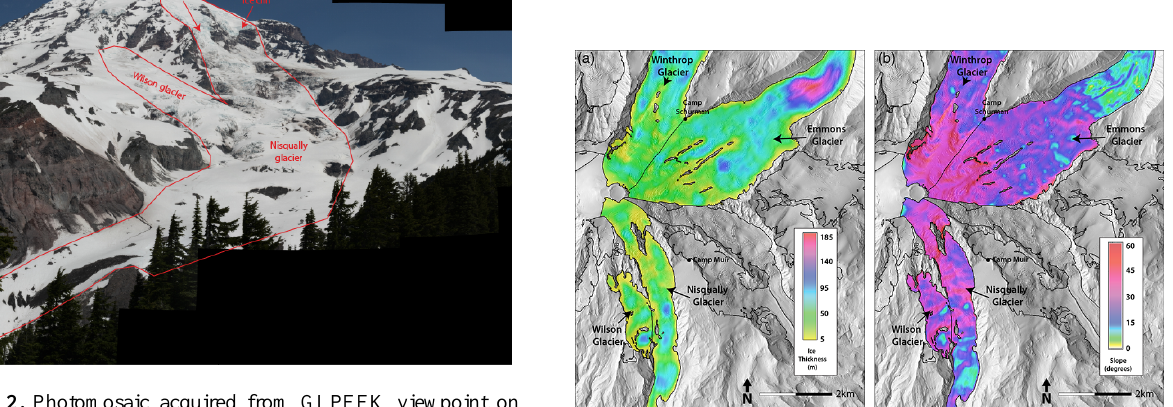
Figure A2. Photomosaic acquired from GLPEEK viewpoint on 6 July 2012. Approximate glacier outlines shown in red.